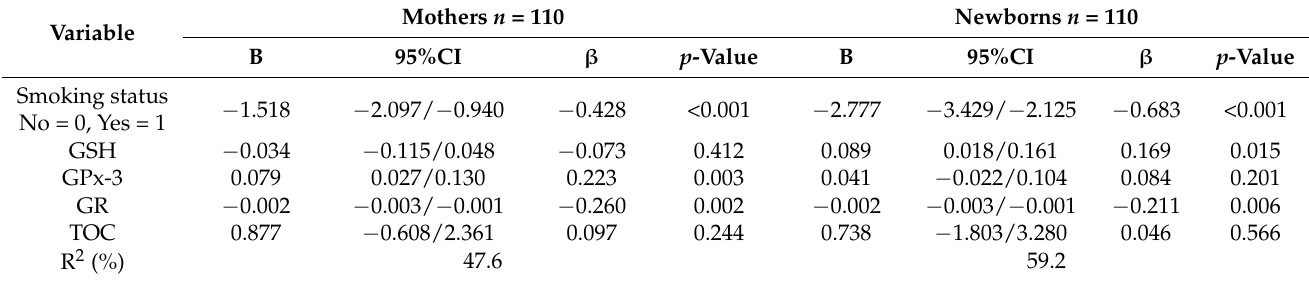
Table 3. Multivariate regression model for GSSG in pregnant women and umbilical cord